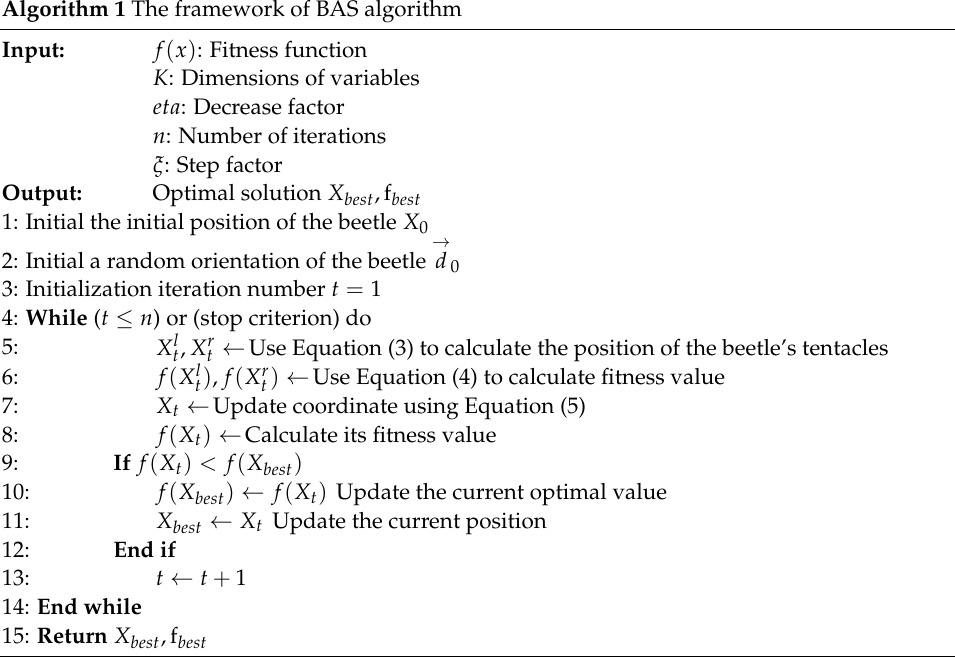
Algorithm 1 The framework of BAS